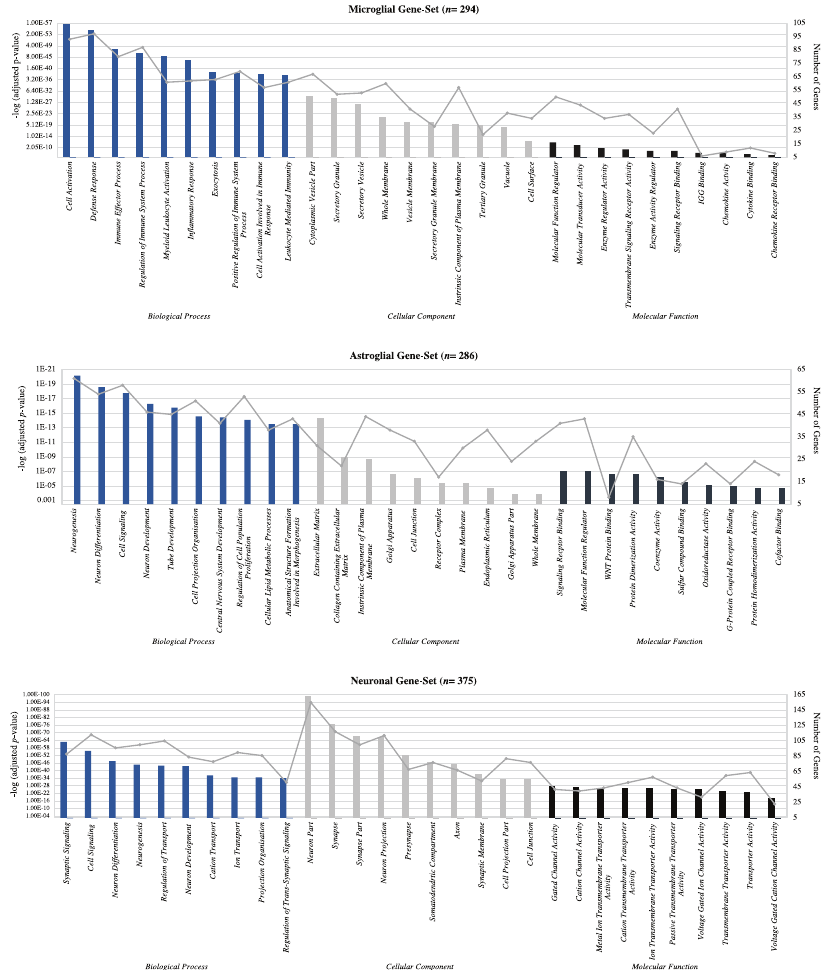
Fig. 1 Gene ontology enrichment analysis. GO enrichment analysis for the top ten biological processes (BPs), cellular components (CCs) and molecular functions (MFs) of the microglial, neuronal and astroglial gene-sets. Analyses indicated that these gene-sets were good representations of each cell types speci fi c functioning. The line plot displays the numbers of differentially expressed genes in each speci fi c function. The bar plot displays the adjusted p values (FDR (false discovery rate) < Table S4 (see Table S5 for UK Biobank participant details). Pearson ’ s product-moment correlation coef fi cients were fi rst carried out to test an association between the SZ-PGSs and covariates of no interest. Results indicated no association between the SZ-PGSs and age, sex, or years in education in either sample. Further, in our discovery sample of patients, no associations between the SZ-PGSs, the severity of symptoms or medication dosage (as measured in terms of chlorpromazine equivalents) were found. Association between microglial SZ-polygenic scores and cognition For the regression analyses, which included the full discovery sample, microglial SZ-PGS signi fi cantly predicted variation in